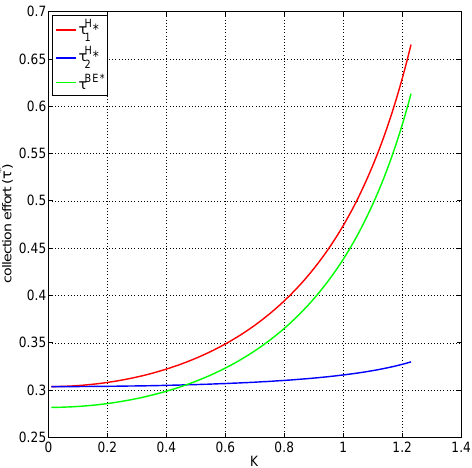
Figure 8. The influences of K on the collection effort τ .